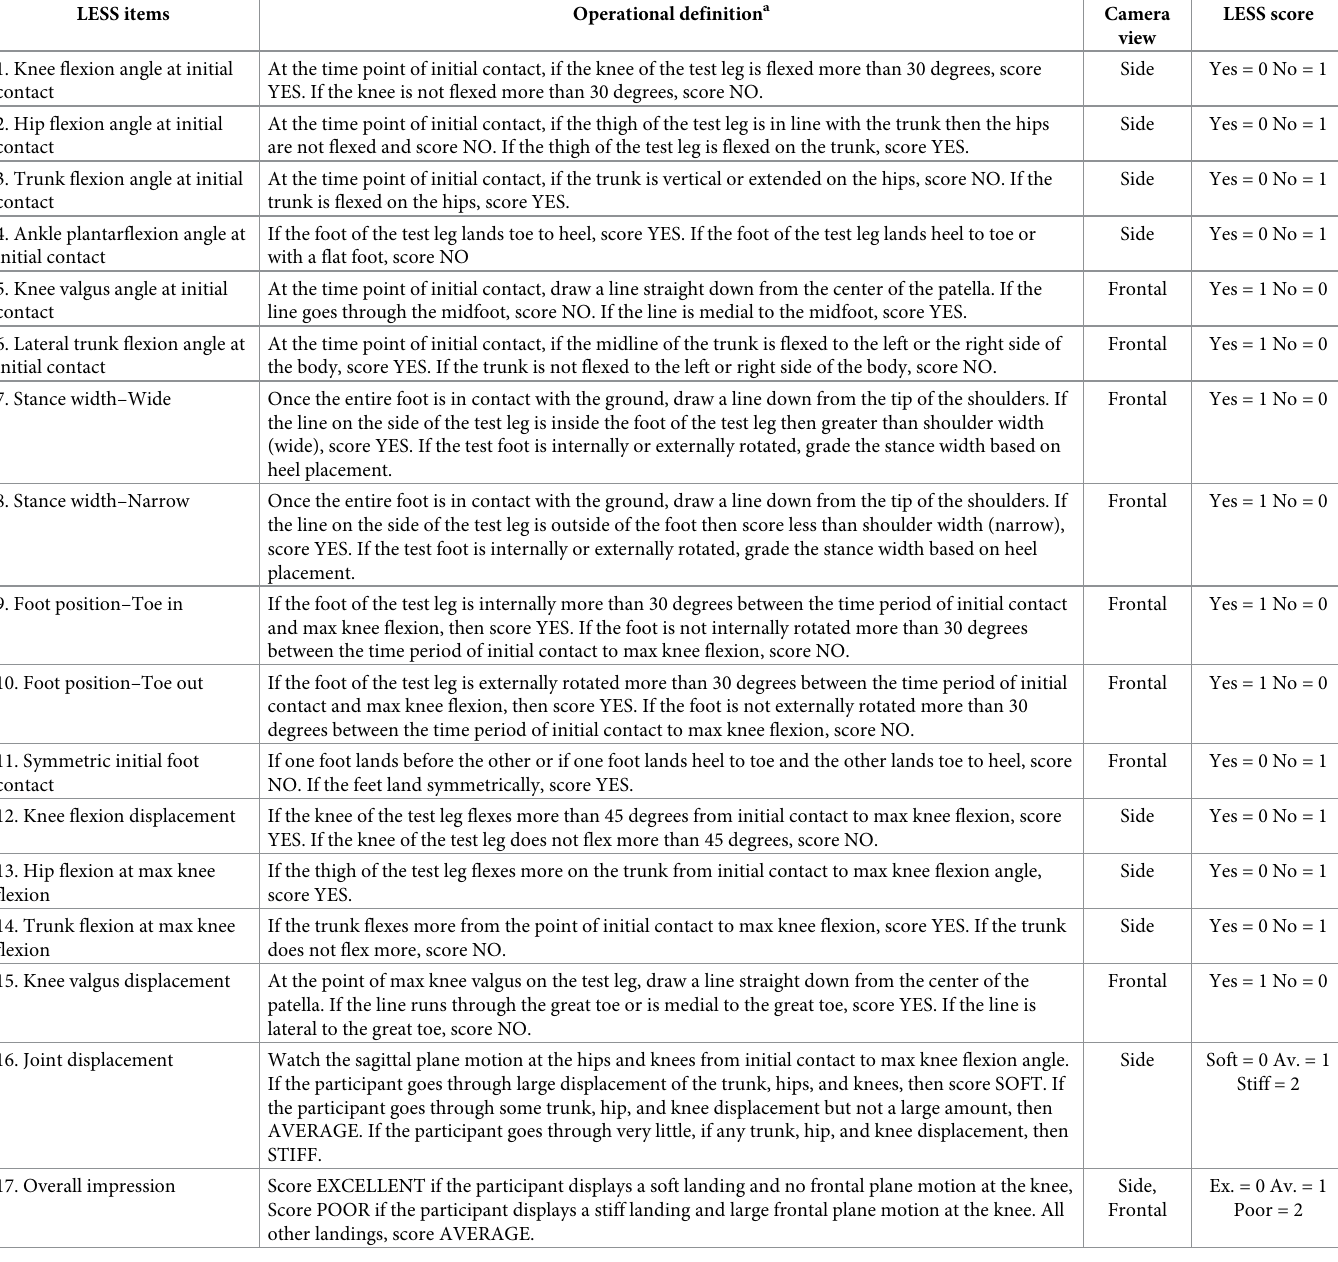
Table 1. LESS items (scoring: 0 = best to 19 = worse landing